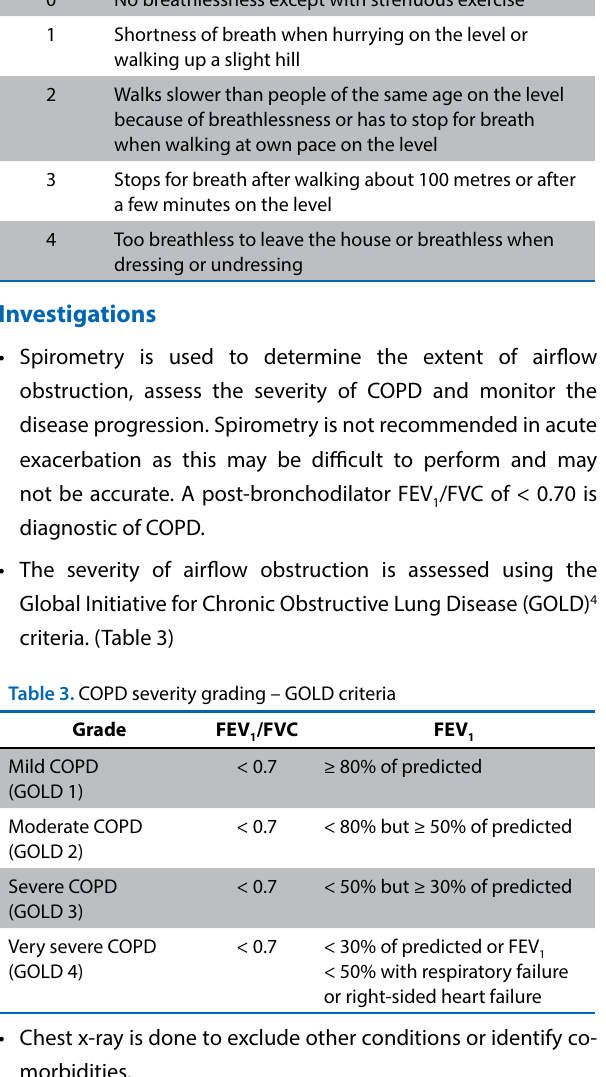
Table 2. Modified British Medical Research Council Dyspnoea scale Scale Severity of